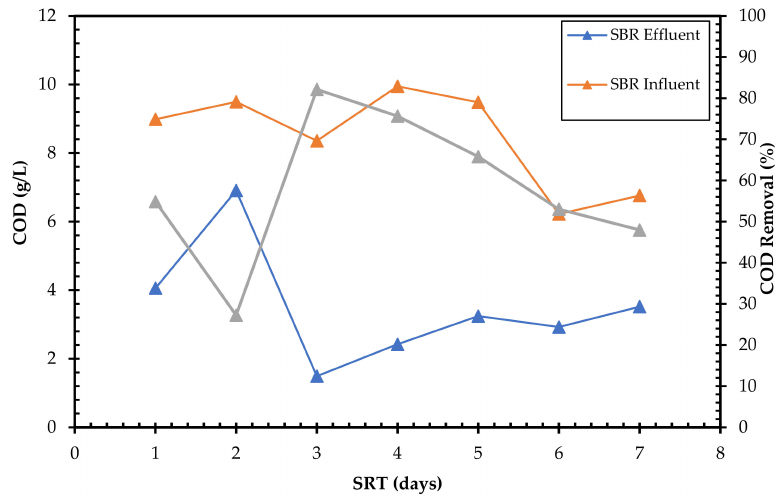
Figure 4. COD removal with SRT